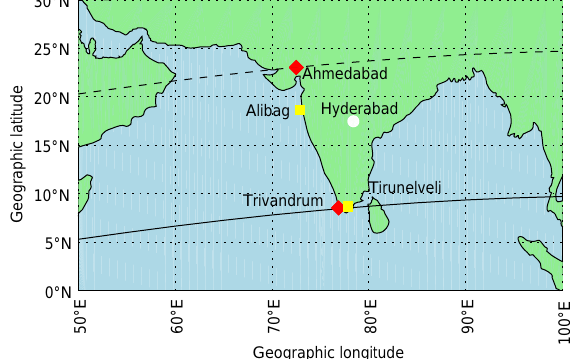
Figure 1. The geographic locations of the stations from which data have been obtained are shown. Neutral optical dayglow emission data have been obtained by MISE commissioned at Hyderabad (white dot). The ionospheric data obtained from digisondes located at Trivandrum and Ahmedabad are shown as red diamonds. Sta- tions from which the magnetic data are obtained to calculate the EEJ strengths are marked as yellow squares. The solid and dashed dark lines represent the geomagnetic equator (obtained from IGRF- 12) (Emmert et al., 2010) and the EIA crest location in the Northern Hemisphere ( + 15 ◦ ), respectively, for the year